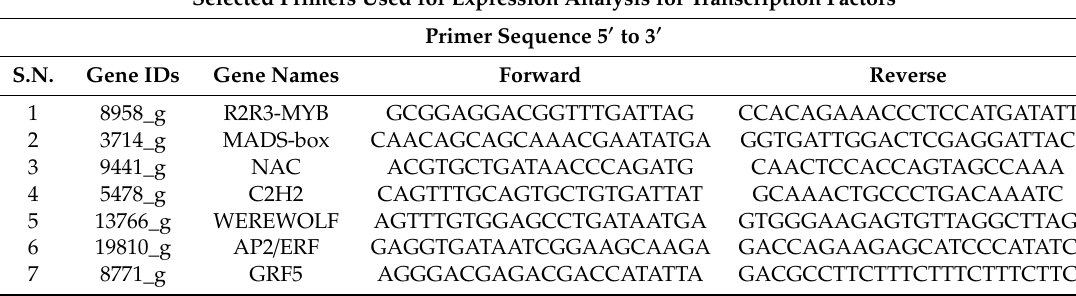
Table 2. List of primers used for expression analysis of transcription factors. Gene IDs are based on annotation for unpublished raspberry genome assembly (Lachesis_Heritage Version 1.1). Selected Primers Used for Expression Analysis for Transcription